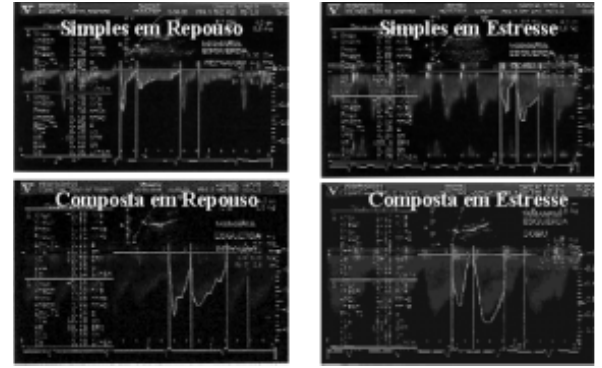
Fig. 3 - Curva de velocidade de fluxo obtida pelo estudo pela ecocardiografia Doppler da ATIE, em ambos os grupos em repouso e em